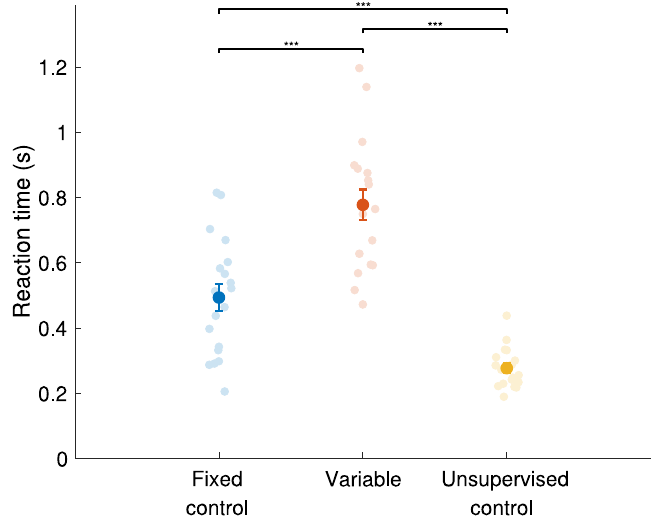
Figure 1. Mean reaction time during the training segment, defined as the time from the last beep to the onset of the first movement. The faint circles are data for all subjects, dark dots are the mean, error bars are the standard error for each group, the black bars indicate significant between-group differences. ***p ≤ 0.001in post- hoc t-tests. N = 19 for all